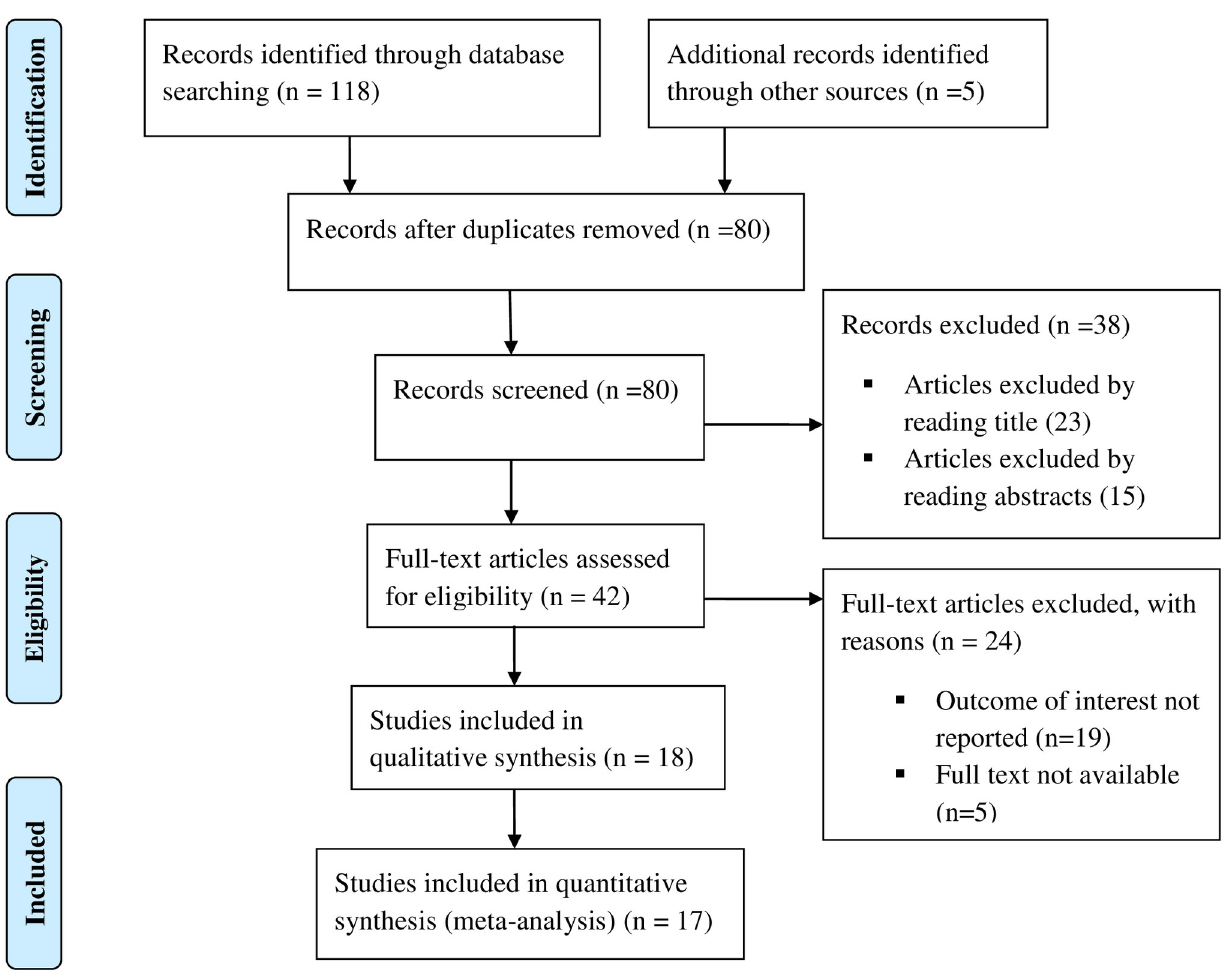
Fig 1. Flow chart of study selection for systematic review and meta-analysis on the prevalence and associated factors of intestinal parasitic infections among street living people and prison inmates.